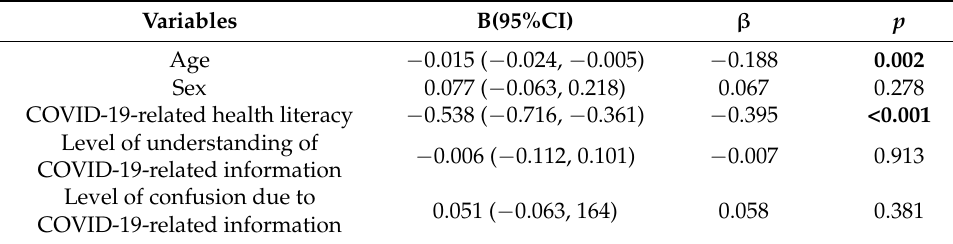
Table 5. Associated factors of attitude about vaccine via multiple linear regression analyses